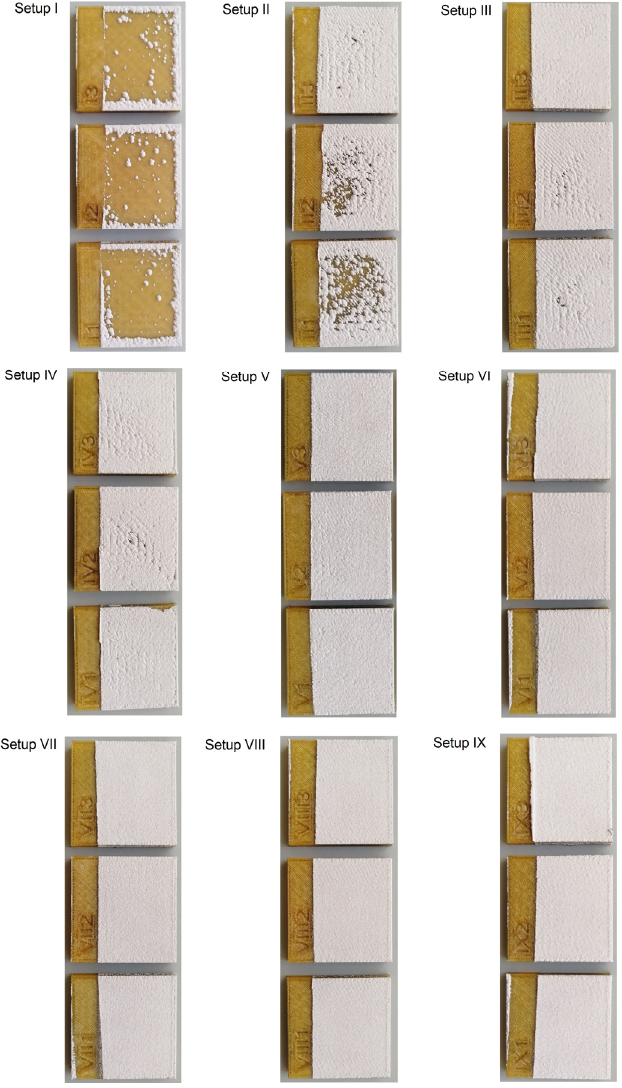
Figure 6. Plasma-sprayed samples for each experimental setup.